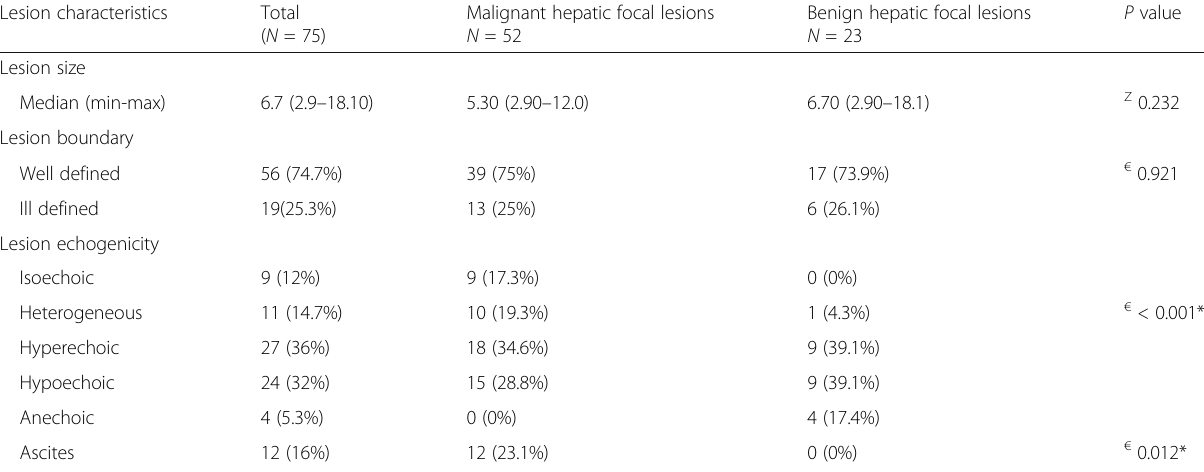
Table 2 Lesion characteristics among the studied groups Lesion characteristics